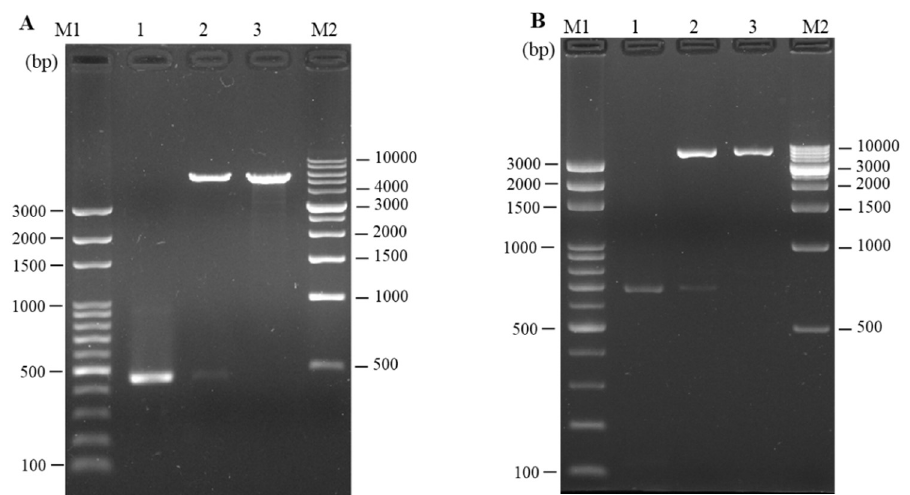
Figure 3. (A) Identification of recombinant plasmid pcHrp1 with PCR and enzyme digestion; M1: DNA marker (100 bp); lane 1: PCR product of Hrp1 gene (459 bp); lane 2: digestion of plasmid pcHrp1 with Nhe I and Hind III ; lane 3: digestion of plasmid Hrp1 with Nhe I ; M2: DNA marker (1000 bp). (B) Identification of recombinant plasmid pcIL-34 with PCR and enzyme digestion; M1: DNA marker (100 bp); lane 1: PCR product of IL-34 gene (693 bp); lane 2: digestion of plasmid pcIL-34 with Hind III and EcoR I ; lane 3: digestion of plasmid Hrp1 with HindIII ; M2: DNA marker (1000 bp).